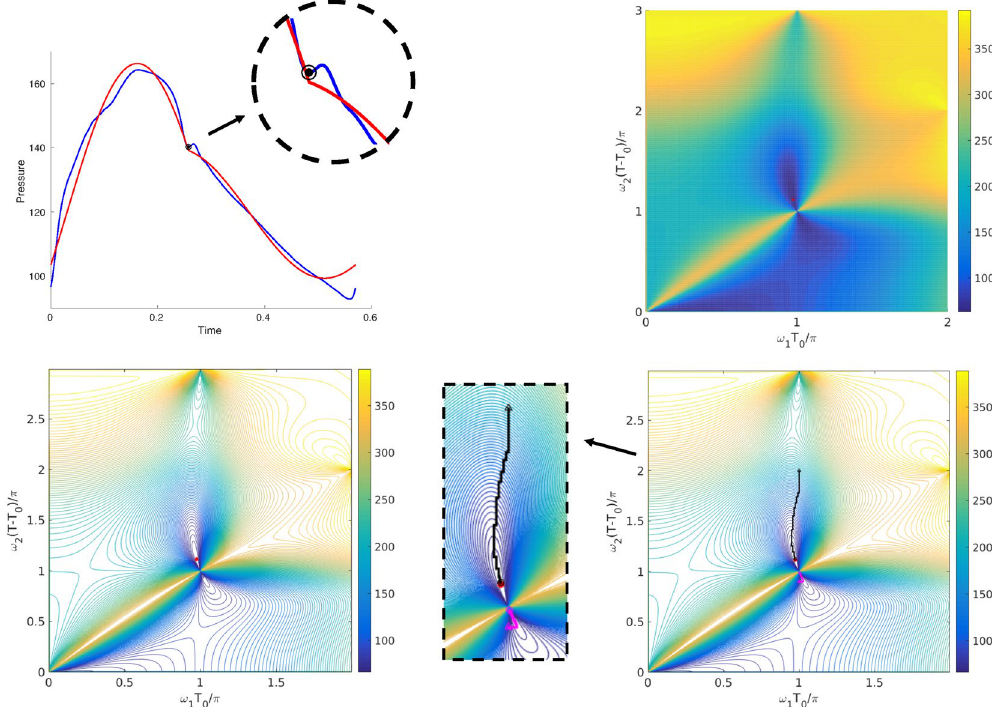
Figure 2. Up-Left: A dog aortic pressure cycle (in blue), its dicrotic notch (black circle with dotted center), and the IMF (in red). Up-Right: heat-map plot of ω solution marked with red dot. Down-Left: Contour plot of ω is shown by a red dot. Down-Right: Contour plot of ω tracked by the pattern search. The beginning of the pattern search is marked with a triangle and its end with a circle. The true optimum point is marked with a red dot. The upper pattern search set (in black) has converged towards the correct optimum. The lower pattern search set (in magenta) has converged to a local minima near the